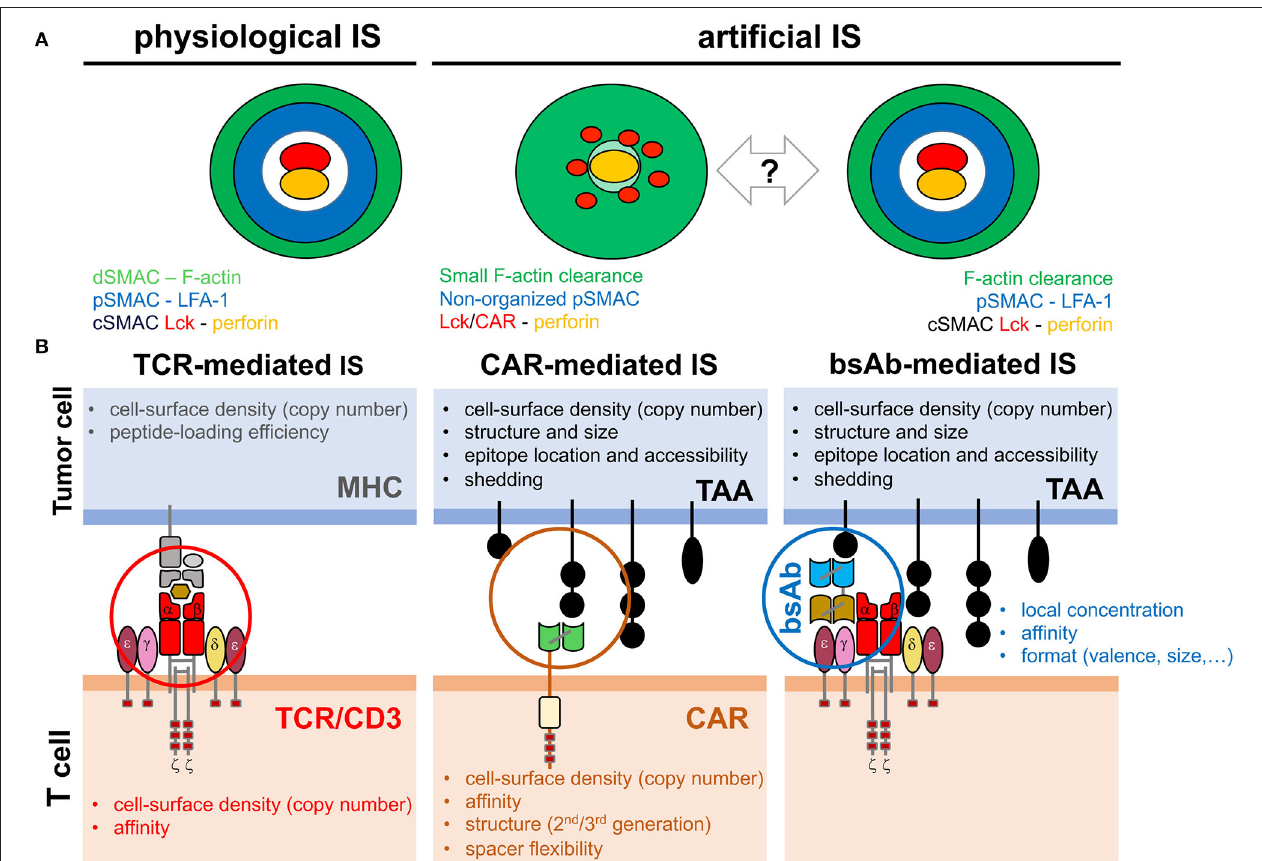
FIGURE 1 | Factors potentially affecting IS topology. (A) Reported topology observed in the TCR-mediated, CAR-mediated and bsAb-mediated IS. The organization of cytoskeleton, signaling and effector molecules along the interface of the IS established by T cells and target cells is depicted. The TCR-mediated and the bsAb-mediated IS display a well-organized bull’s eye structure whereas CAR-mediated IS shows a rather disordered structure. Bidirectional arrow and question mark indicate the uncertainty of expected topology in future CAR and bsAb formats. (B) Schematic of the activating system in TCR-mediated physiological IS or CCB-mediated artificial IS. The different factors influencing IS assembly and T cell activation are indicated in the tumor cell and in the T